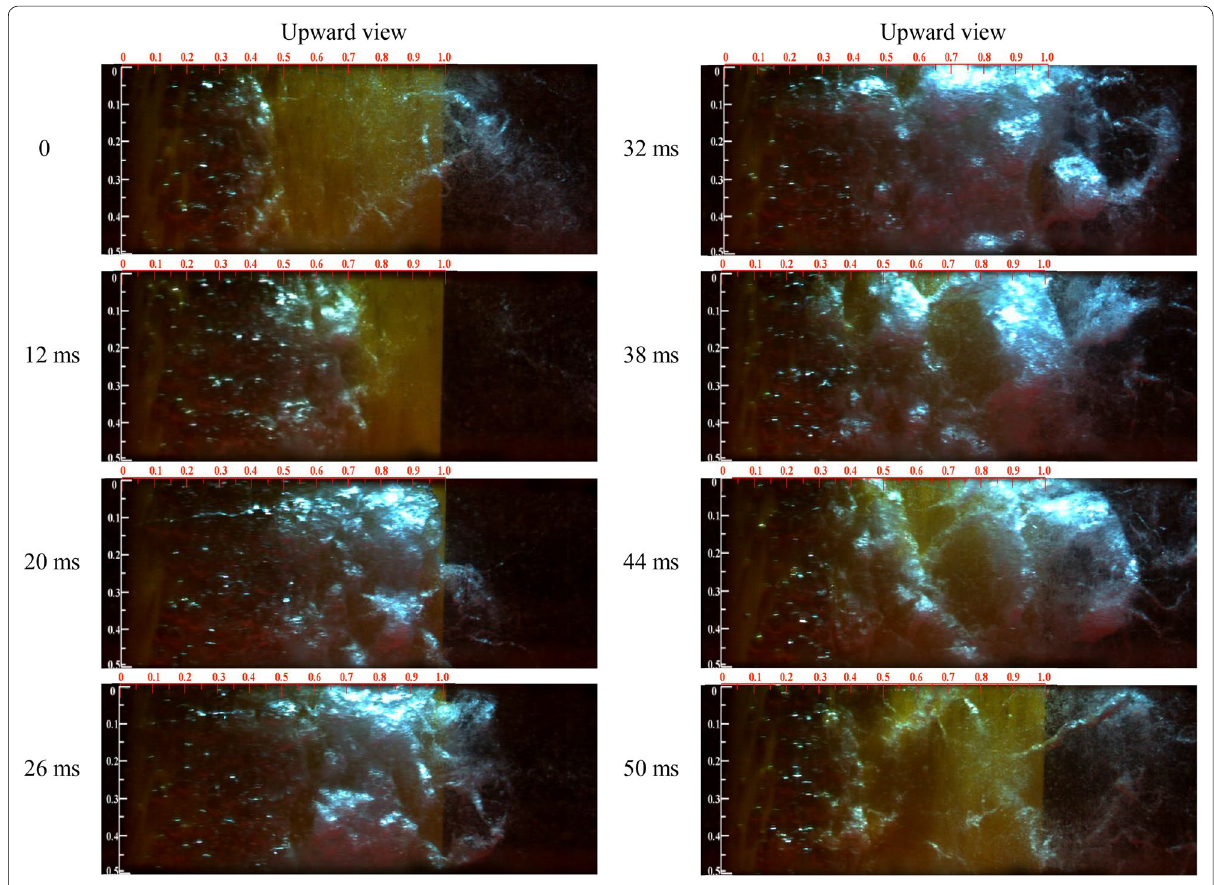
Figure 10 Time evolutions of cloud cavitation around Foil C ( σ